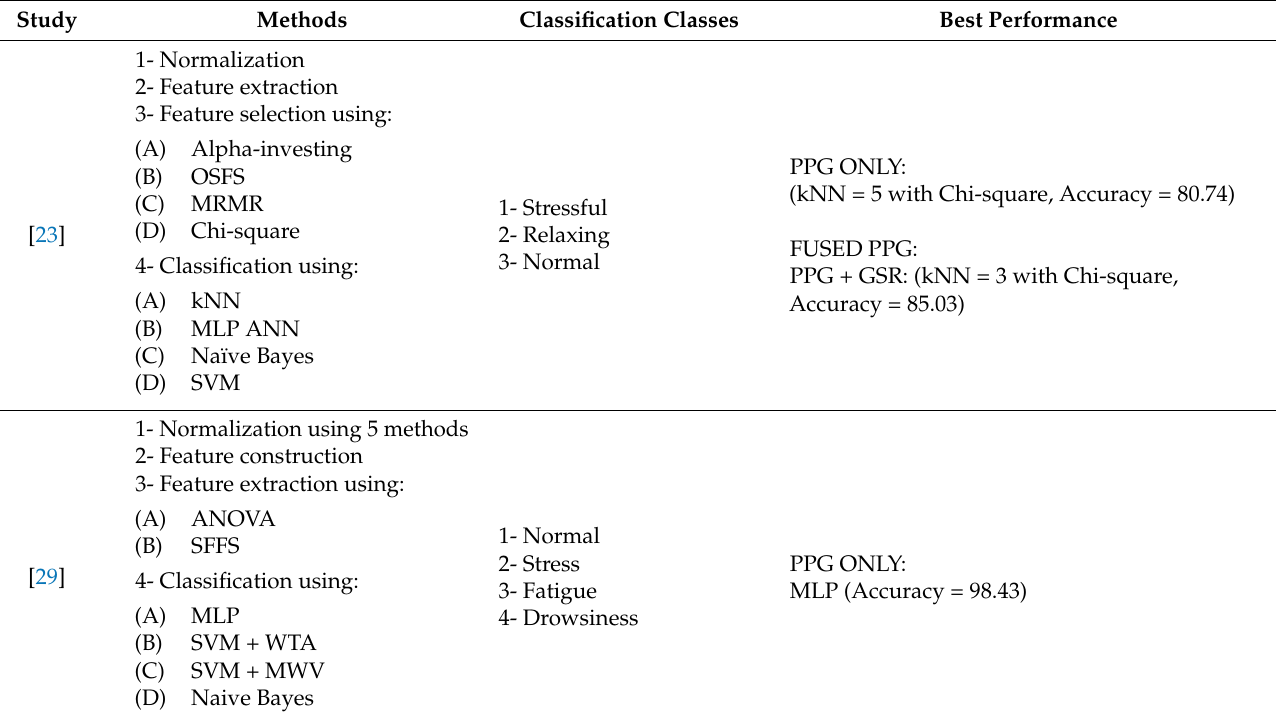
Table 5. Stress detection studies using ML-based